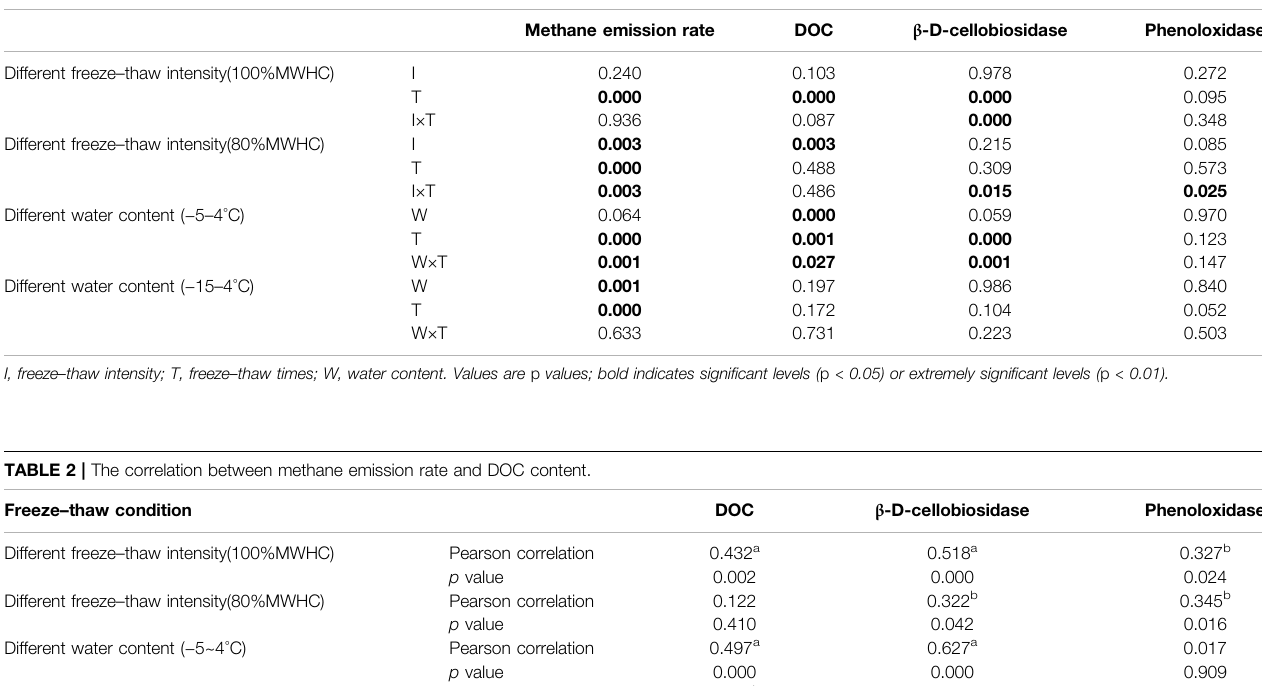
TABLE 1 | MANOVA results of enzyme activity in different freeze – thaw patterns.